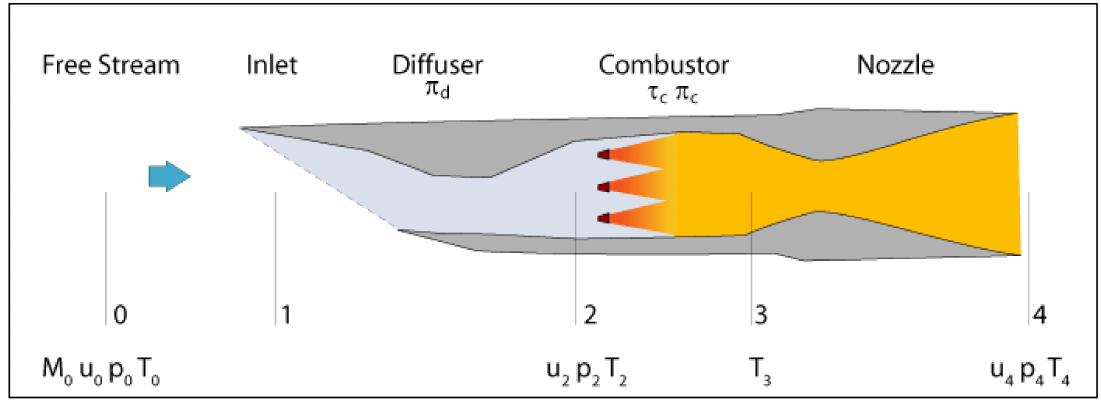
Figure 3. Thermodynamic stations of a